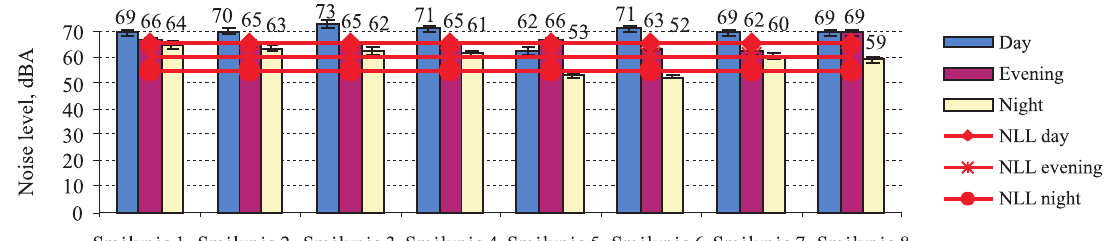
Fig. 5 . Change of equivalent noise levels in Smėlynės street in the course of a day (NLL – noise level